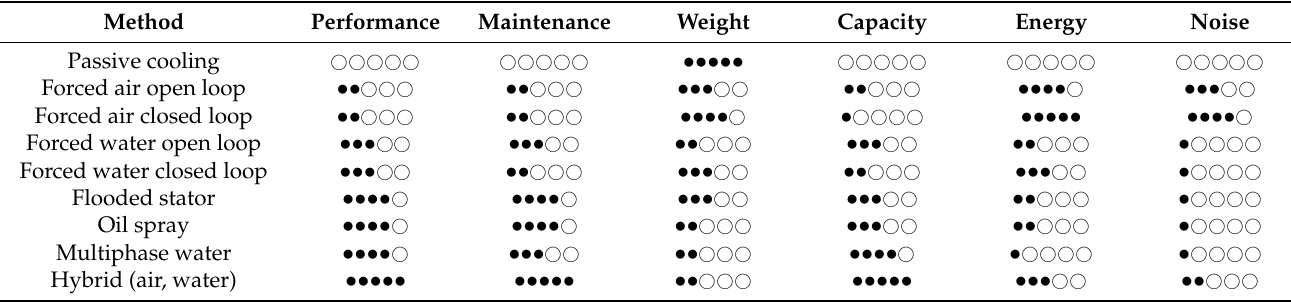
Table 4. Summary of cooling